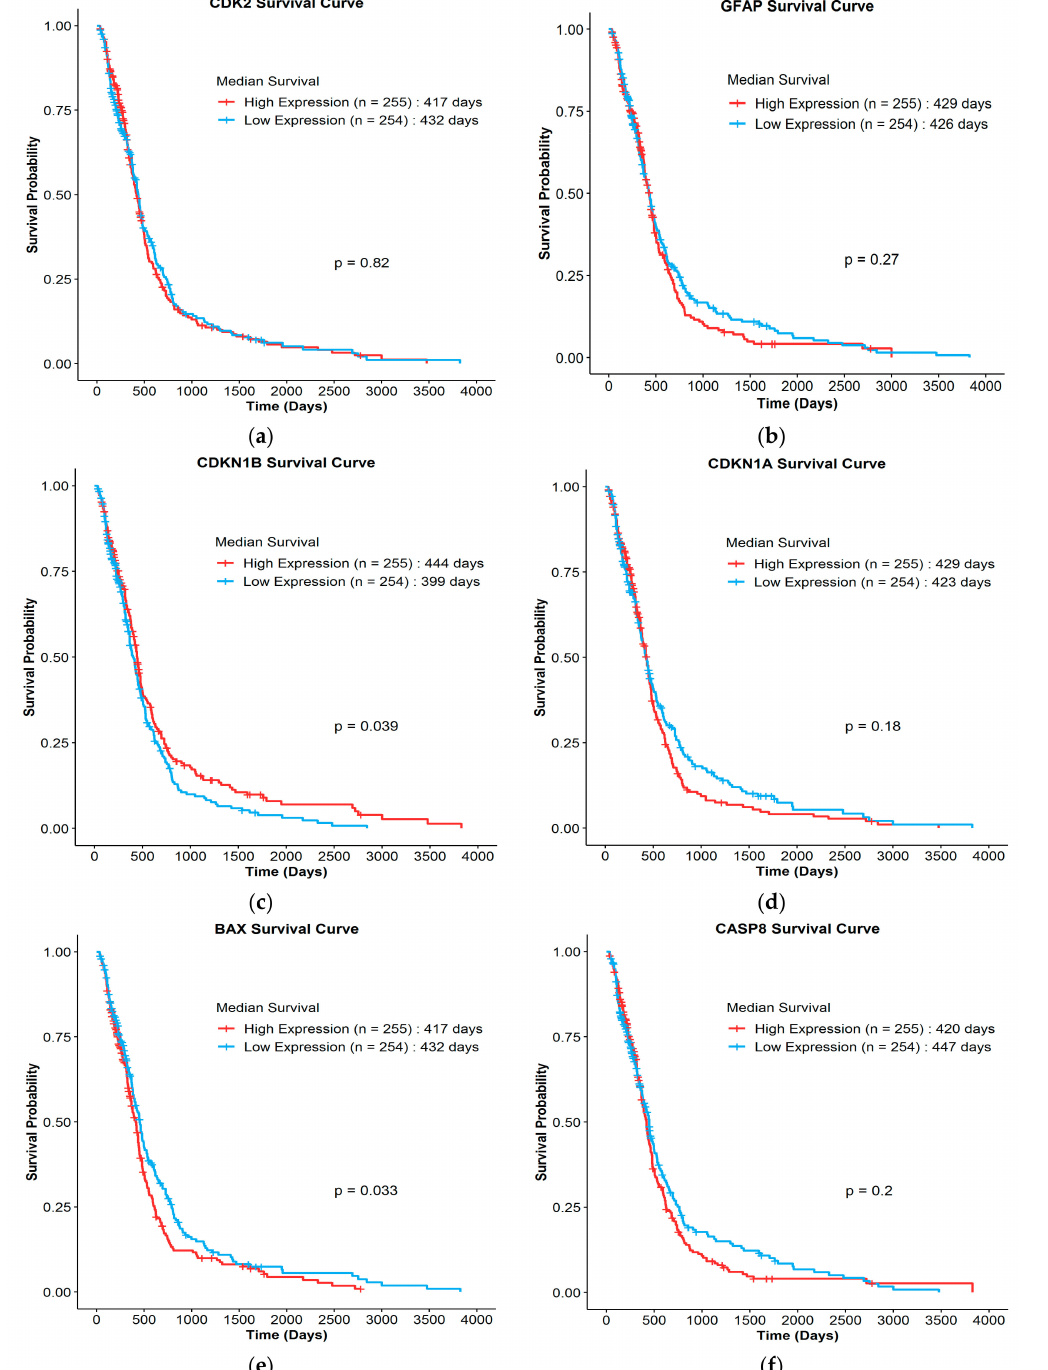
Figure 5. Kaplan–Meier survival analysis plot of 509 GBM patients from TCGA with an overall survival of more than 30 days based on the expression of genes correlated to the replicable biomarkers: grouped based on the median expression patterns into high and low expression groups using the log-rank test (a p -value of <0.05 indicates a statistically significant